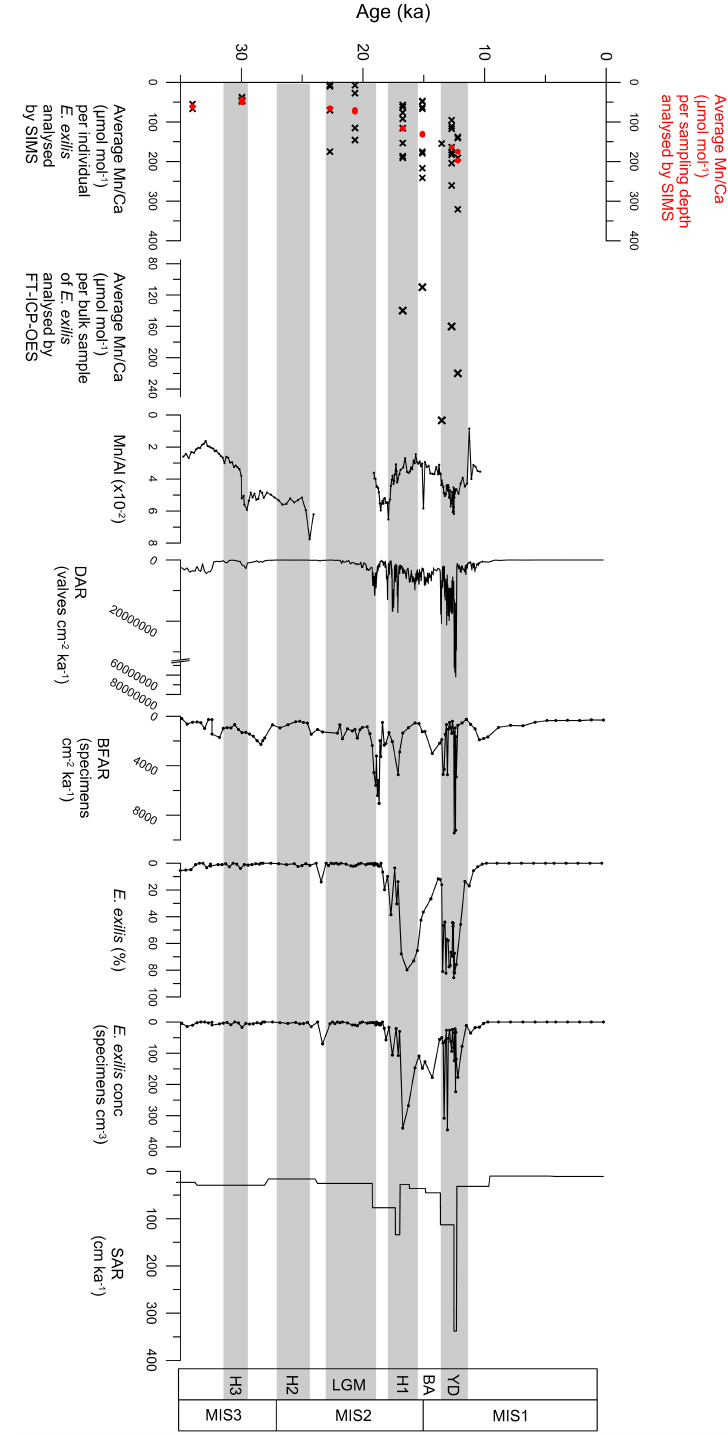
Figure 4. Foraminiferal Mn / Ca (µmolmol − 1 ) determined by SIMS (black crosses: average per specimen; red circles: average per depth) and FT-ICP-OES; bulk sediment Mn / Al (Gallego-Torres et al., 2014); diatom accumulation rate (DAR; Romero et al., 2008), benthic foraminiferal accumulation rate (BFAR; McKay et al., 2014); relative abundance and concentration of low-oxygen-indicating Eubuliminella exilis and sediment accumulation rate (SAR) of core